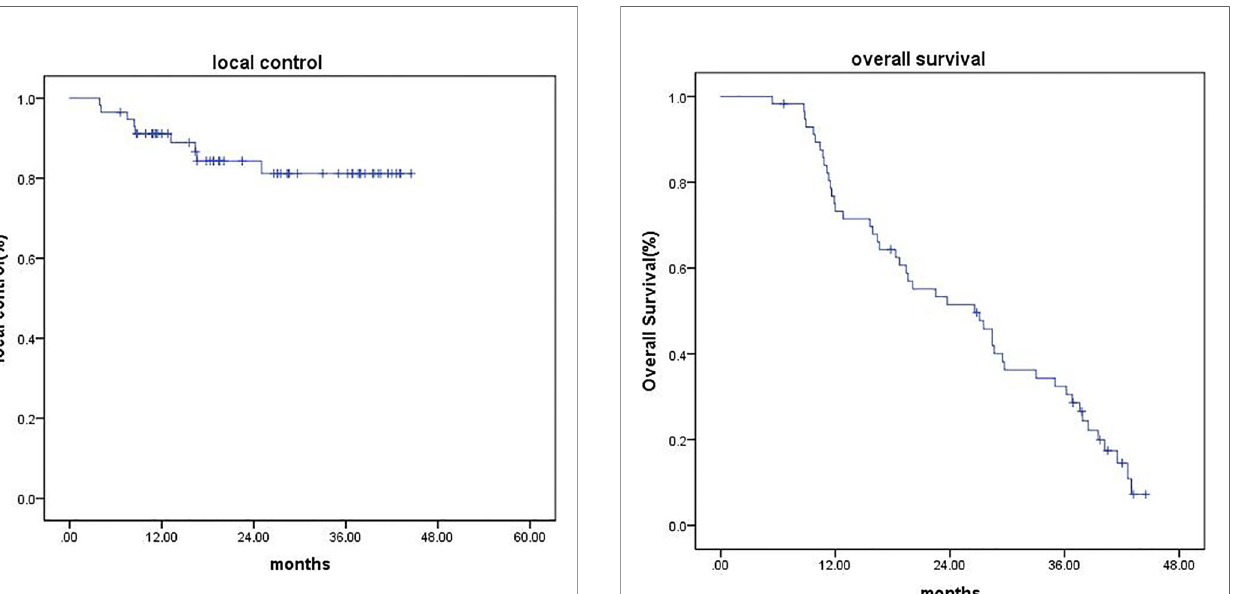
FIGURE 1 | Kaplan – Meier analysis of LC.